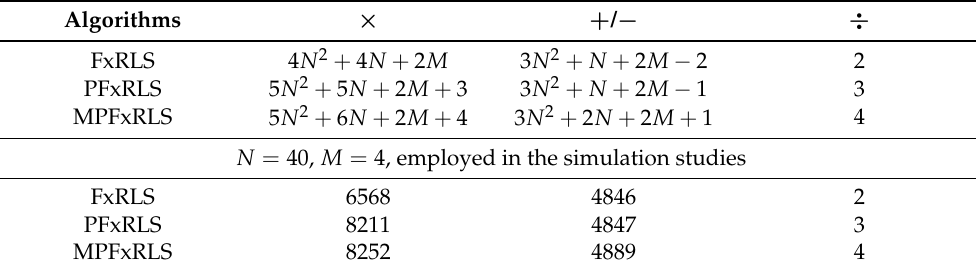
Table 1. Computational complexity comparison of FxRLS, PFxRLS and